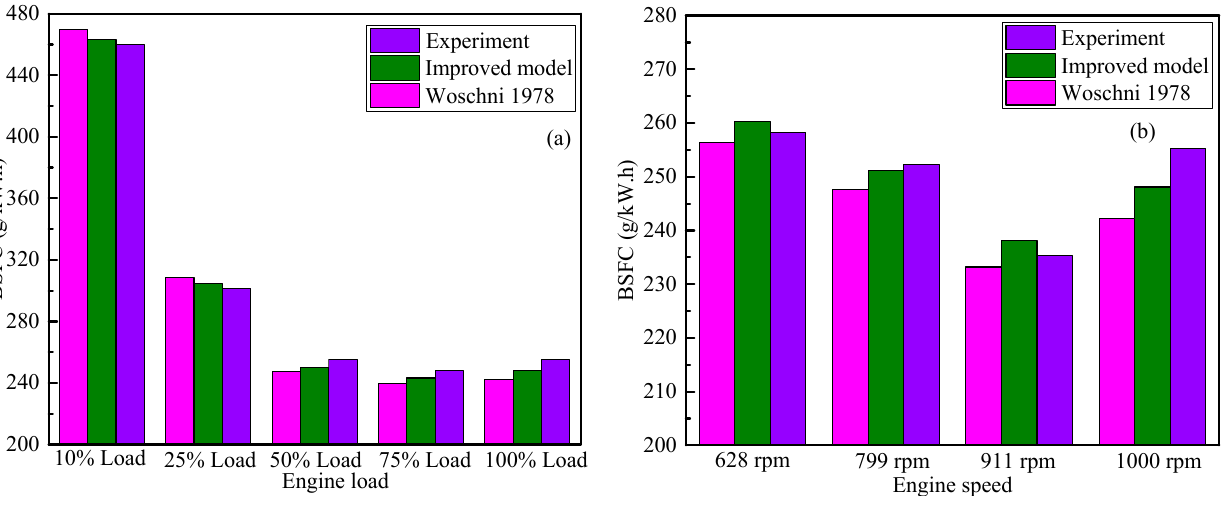
Figure 4. Comparison of BSFC under different load